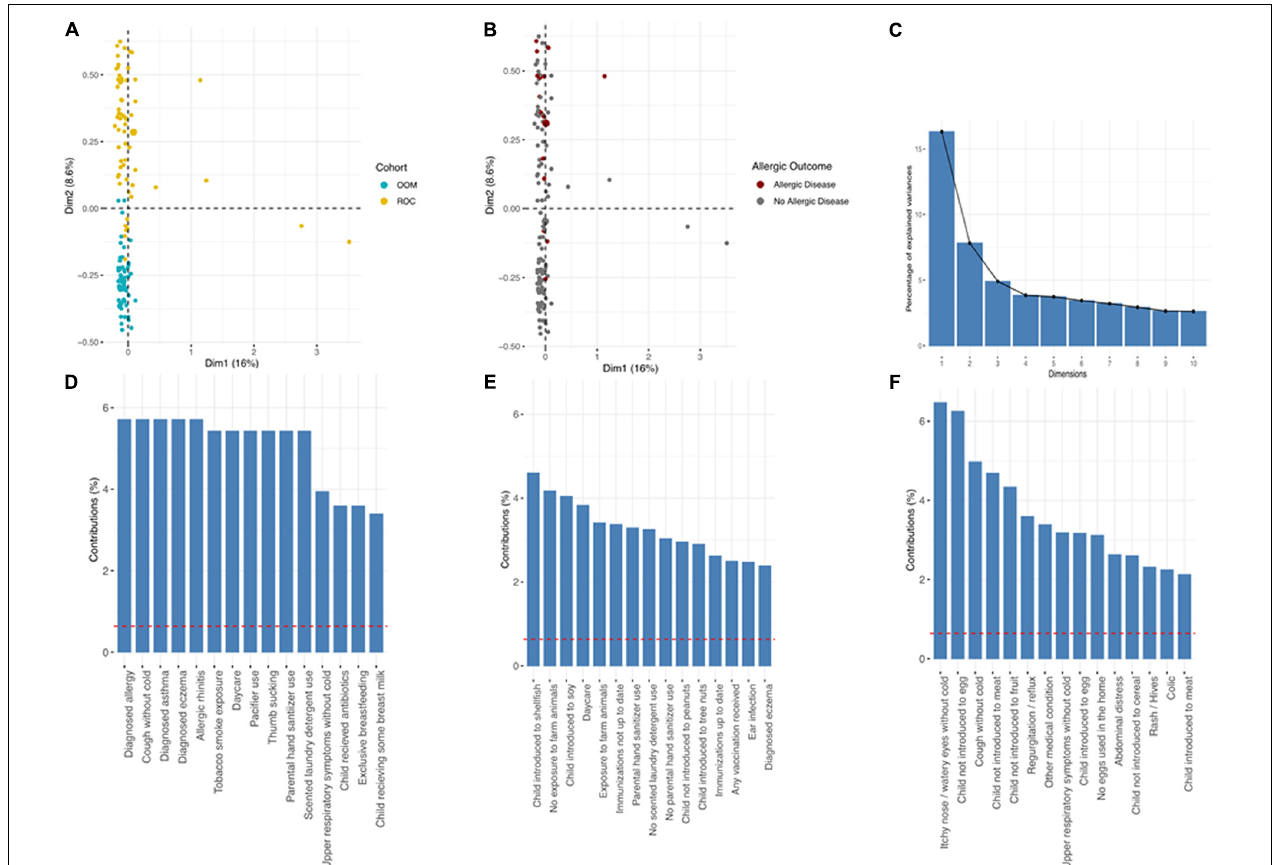
FIGURE 4 | Multiple correspondence analysis (MCA). (A) Scatter plot depicting OOM vs. ROC cohort, (B) scatter plot depicting physician diagnosis of allergic disease by clinical diagnoses (not parental report in surveys). (C) Scree plot depicting % variation explained by each dimension and the 15 variables with largest contribution in dimension (D) one, (E) two, and (F)